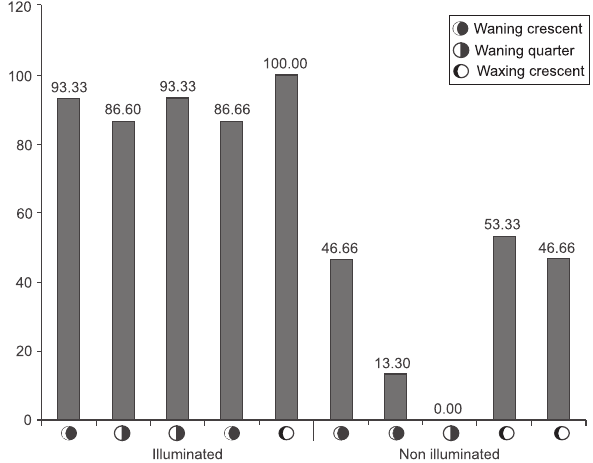
Figure 4. Percentage of emergence events diverted in function of the lunar phase and in illuminated and non-illuminated areas. Data based on ten experimental events in different lunar conducted in Merepe Beach, coast of Ipojuca, Pernambuco, Brazil.